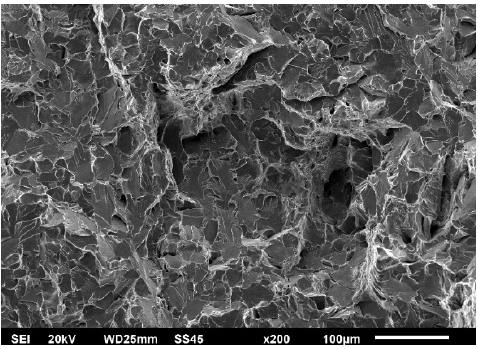
Figure 17. SA ‐ 387 Gr. 91 WM fractography, CT specimen 575 °C, 200×.